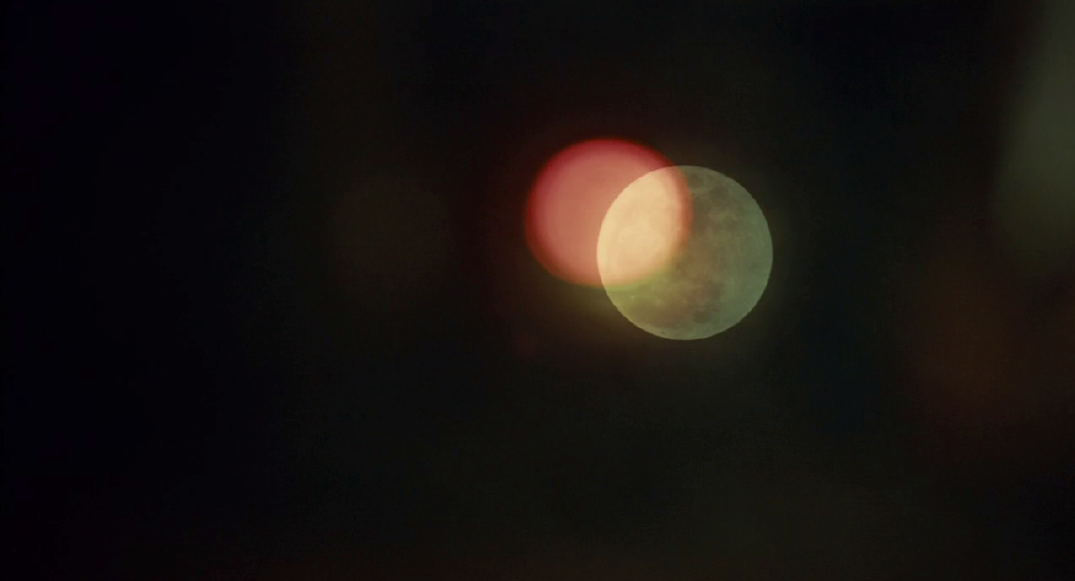
Figure 5 . The fuel-air mixture ignited by the spark explodes into brown and orange. Screencap from Hannibal , season 3, episode 1, “Antipasto.”